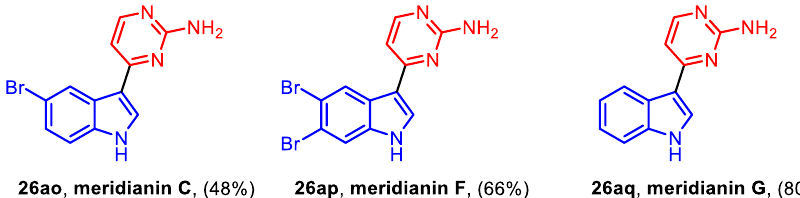
Figure 21. Meridianins 26ao-aq synthesized through MBSC sequence by Kruppa et al. [49].